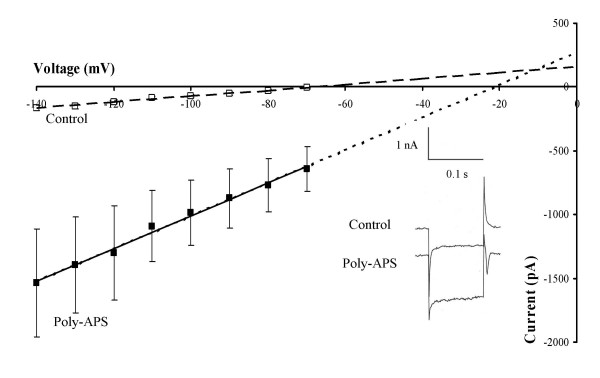
Poly-APS activated inward currents in cultured hippocampal neurones. Mean current- voltage relationships plotted under control conditions (broken line) and after activation of inward current by 0.5 μg/ml poly-APS (solid line). Poly-APS application produced an inward cation current with a linear current/voltage relationship. Inset records show currents evoked by step depolarisations to -140 mV from a holding potential of -70 mV under control conditions and in the presence of poly-APS.